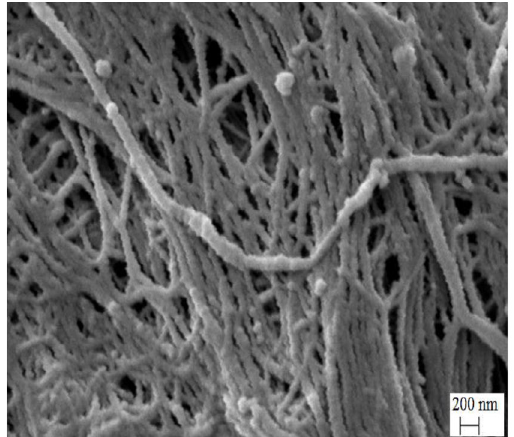
F ig. 7. The chromatogram of a) unprocessed and b) processed paclitaxel in DMSO/water ratio of 6 (v/v), ethanol concentration of 7.5%, pressure of 20 MPa, the temperature of 50 ºC and flow rate of 3 CO 2